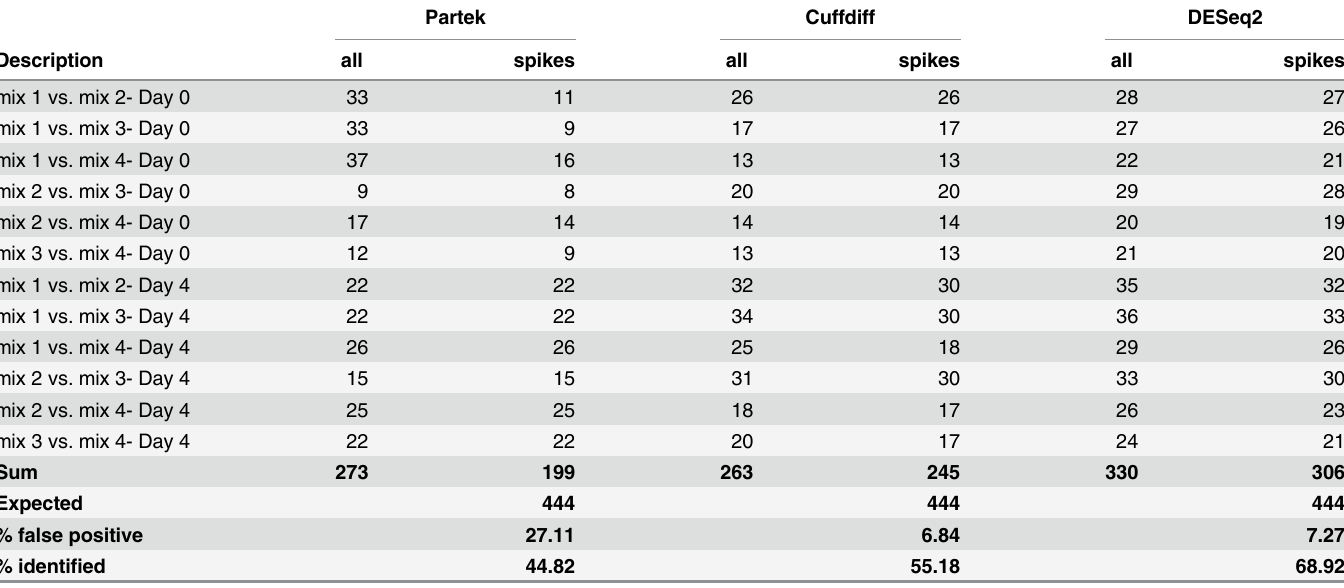
Table 3. Number of differentially expressed genes among the mixes, as identified using various bioinformatics tools using RefSeq+